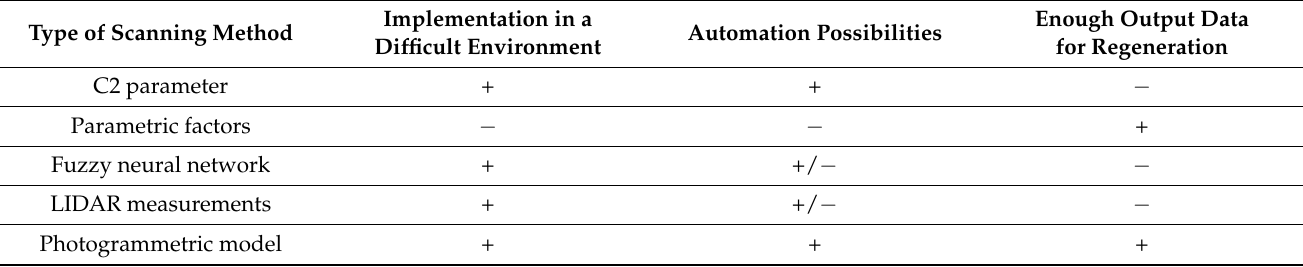
Table 7. Limits of the methods of classification of the picks’ wear and its features. Type of Scanning